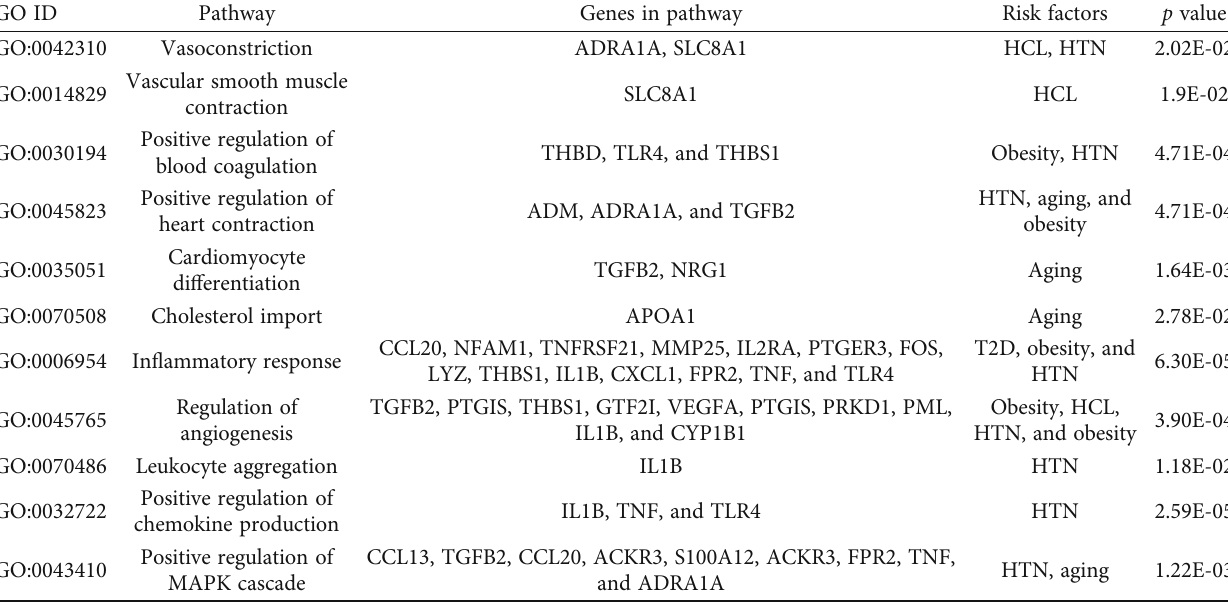
Table 5: Signi fi cant ontological pathways of CVD are also associated in its risk